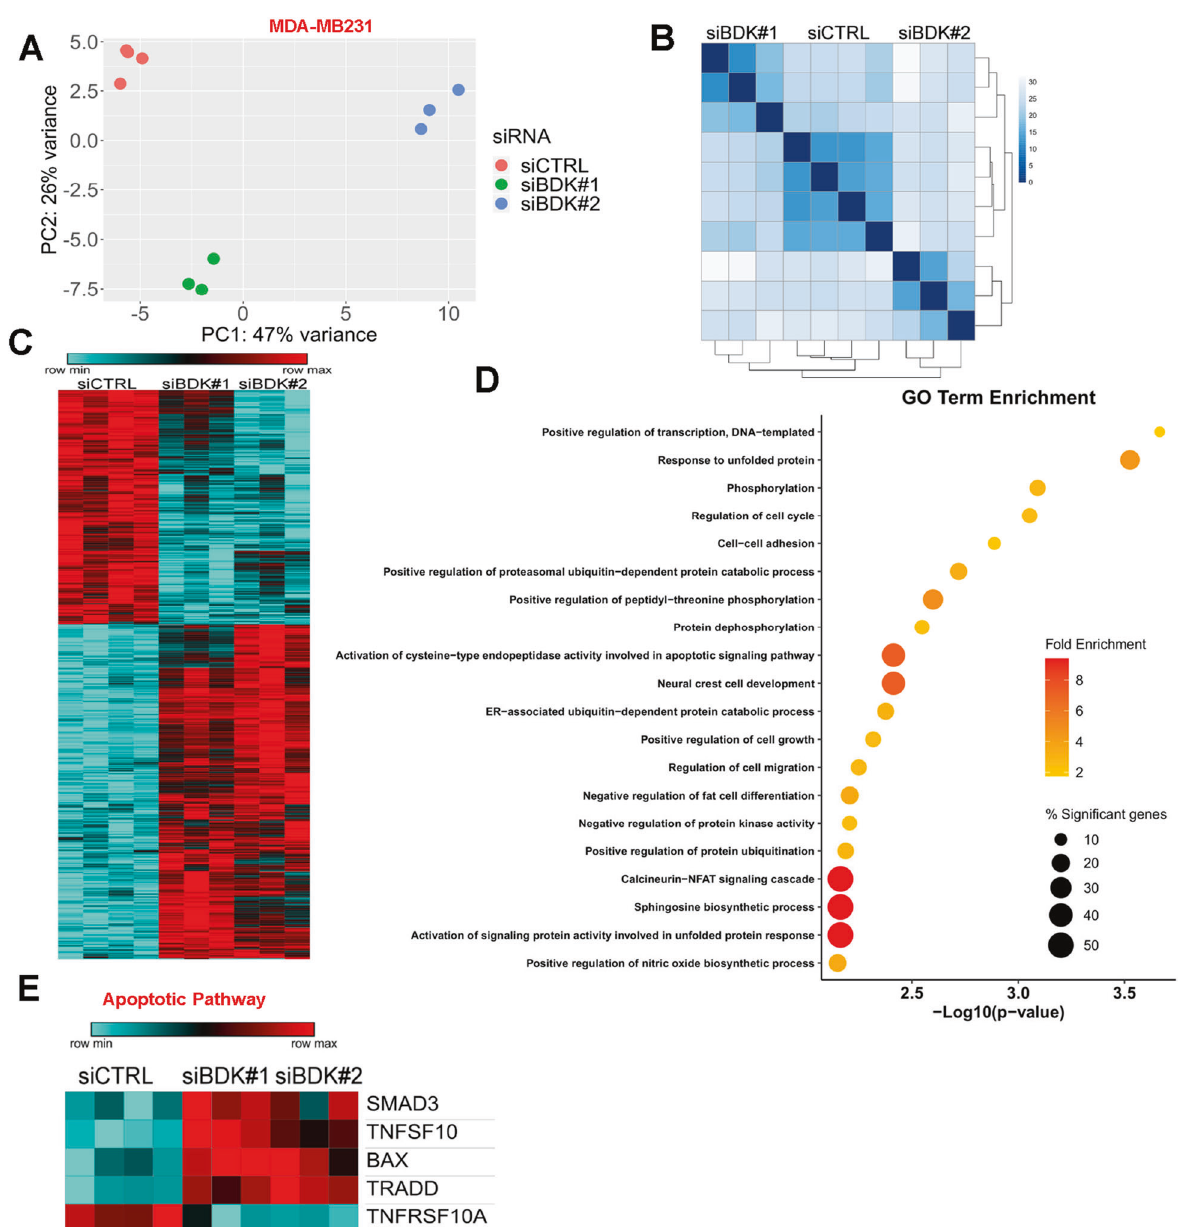
Fig. 4 Differential enrichment of genes related to metabolism and cell death pathways in MDA-MB-231 cells with BCKDK knockdown. A Principle component analysis plot for all gene expressions from MDA-MB231 cells treated with both siRNAs targeting BCKDK. B Distance matrix clustering for all gene expressions from MDA-MB231 cells. C Heatmap for differentially expressed genes from MDA-MB231 cells. D Top 20 most signi fi cantly enriched gene ontology (GO) terms from BCKDK knockdown induced differentially expressed genes. Color represents the fold enrichment statistic, and size represents the percentage of the differentially expressed genes in the gene set compared with the total gene set size. E Heatmap for genes involved in apoptosis which were signi fi cantly differentially regulated by BCKDK knockdown in MDA- MB231